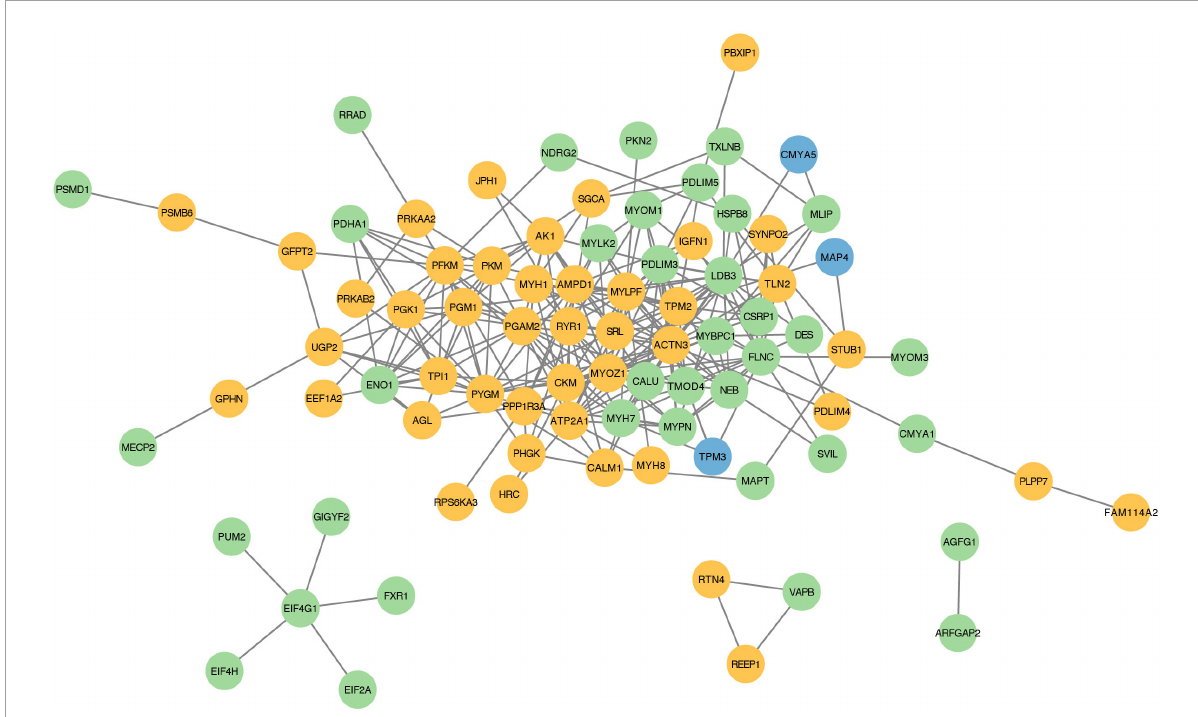
FIGURE6 Protein-protein interaction regulatory network of proteins with DEPSs. Each node represents a phosphorylated protein. Green indicates up-regulated, yellow for down-regulated, and blue for both up- and down-regulated proteins. Each edge represents an interaction between